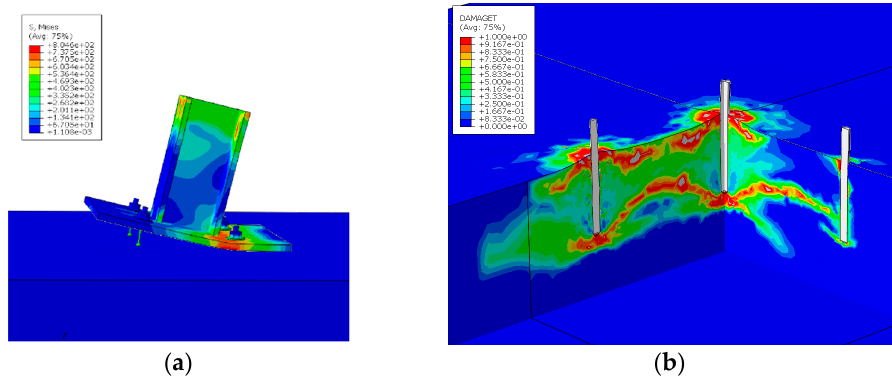
Figure 11. Pushover simulations. ( a ) Anchor yield failure. ( b ) Concrete brittle failure.